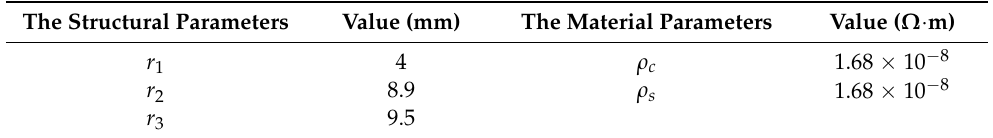
Table 1. The basic structural and material parameters of the object cable 1 .